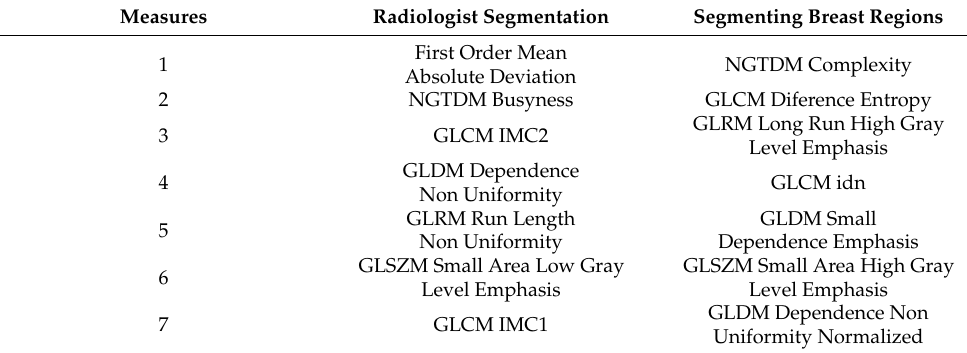
Figure 13. Gene Rank Stability graph with calcification model by radiologist segmentation; the gene rank shows the stability of the top-ranked 50 variables. The horizontal axis shows the genes ordered by rank, and the vertical axis shows the gene frequency. The bottom—coded rank represents the genetic stability, where features with no change in color represent a stable feature; changing color features represent unstable features. Table 3. Comparison between models with CS1 and CS2 calcifications.